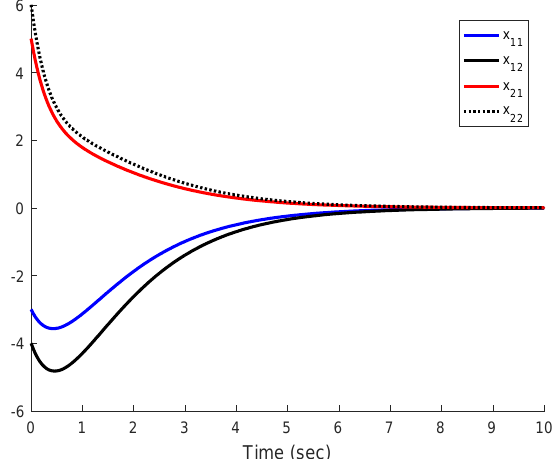
Figure 1. States evolution when the decentralized controller K d is employed.